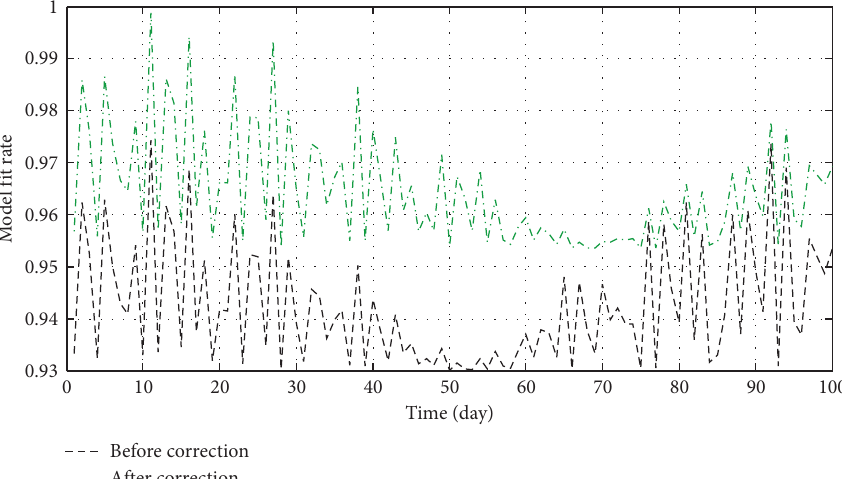
Figure 9: Comparison of the fitness of the premodified hypothetical model and the postmodified hypothetical model in the mature